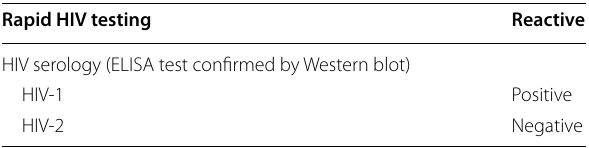
Table 2 HIV testing